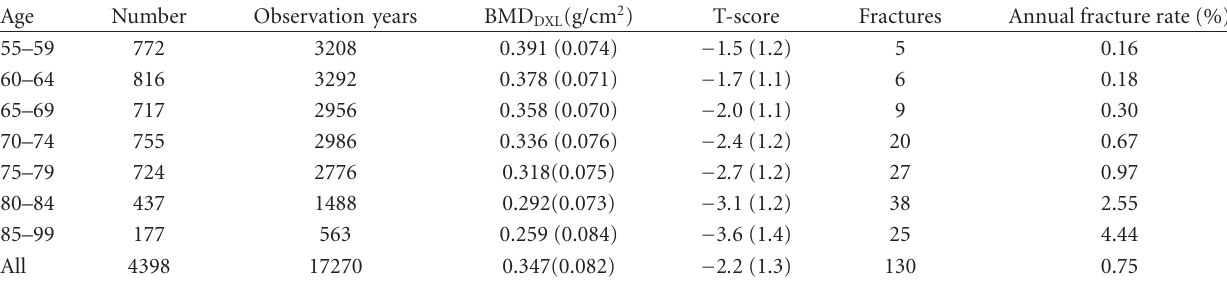
Table 1: The number of individuals per decade, observation years, BMD DXL , T-score with 1 standard deviation within parenthesis, number of fractures and the annual hip fracture rate regardless of BMD DXL .